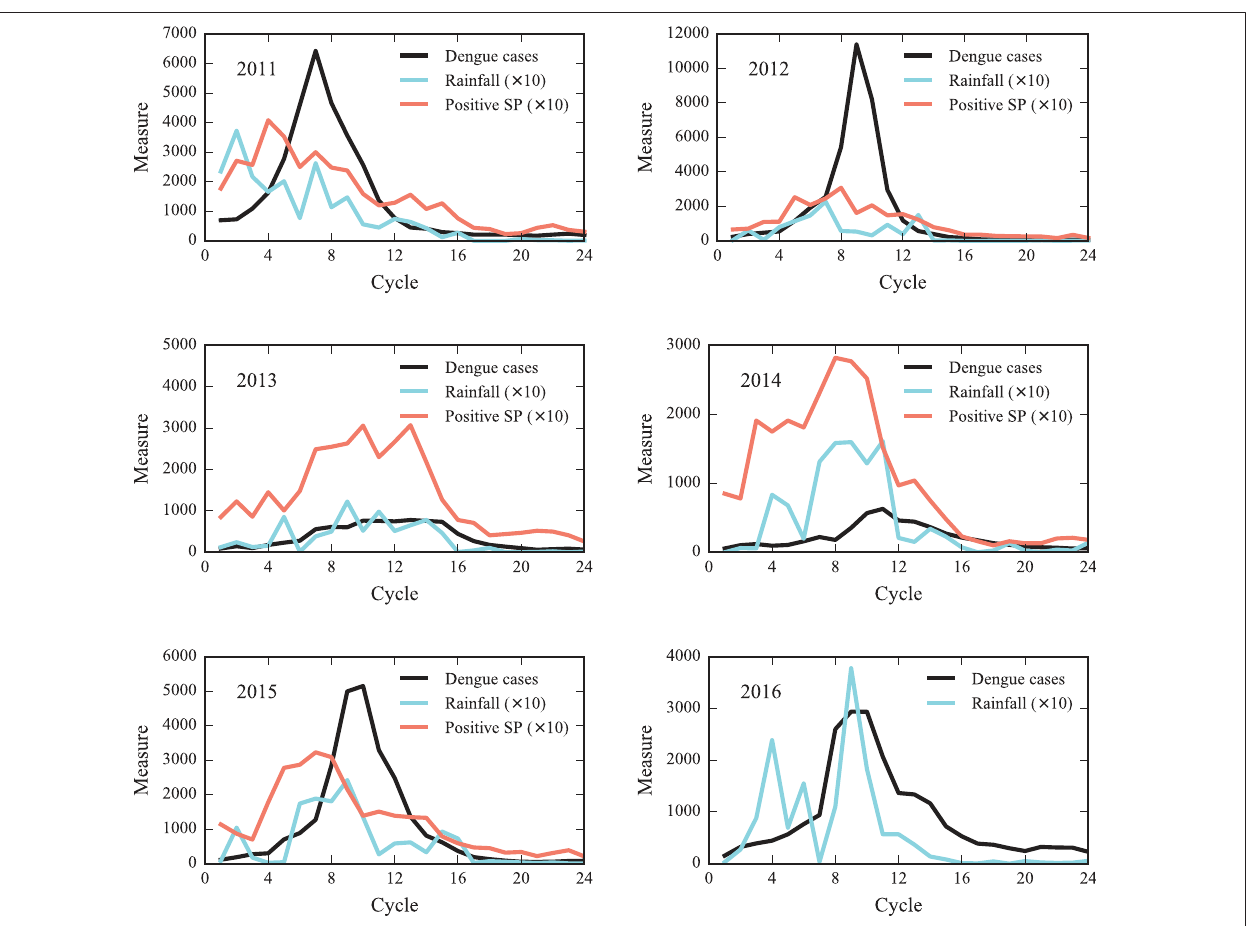
FIGURE 4 | The number ofreported dengue cases, positive SPs and rainfall as afunction of time from 2011 to 2016. For each year from 2011 until 2016, weshow the number of reported dengue cases, positive SPs, and the precipitation level as a function of time. One time interval (cycle) is one fortnight, starting from the fi rst fortnight of the year (cycle = 1). The number of positive SPs and the amount of rain in liters per square meter have been rescaled by a factor of 10. There is no larvae measurement data available for 2016.